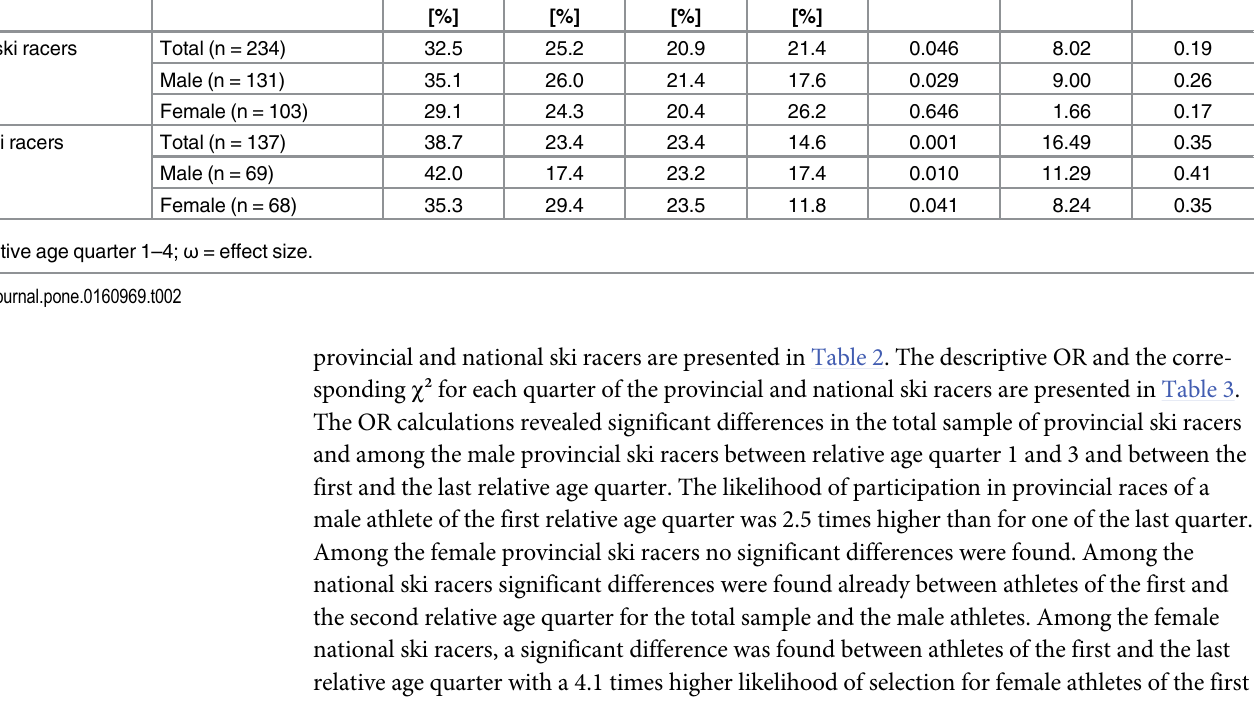
Table 3. Descriptive OR across all relative age quarters according to group of ski racers and gender. sample Q1:Q2 Q1:Q3 Q1:Q4 Provincial ski